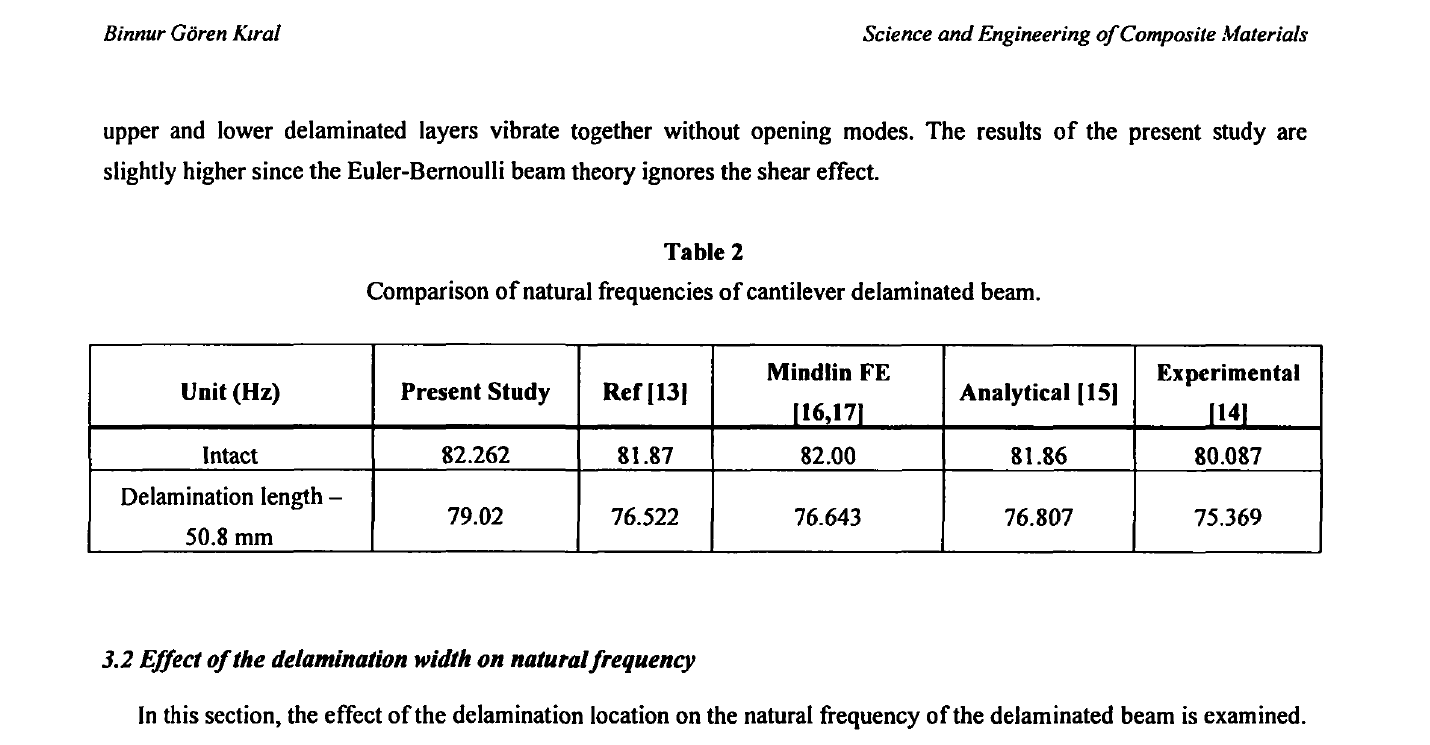
Comparison of natural frequencies of cantilever delaminated beam.